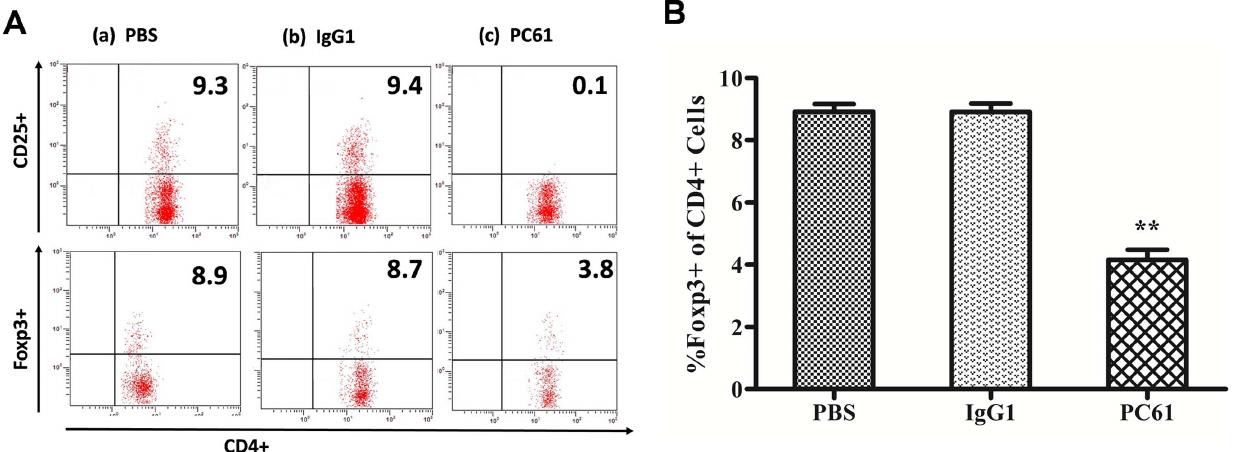
Figure 4. Effect of the injection of PC61 mAb on the Treg cells of normal mice. Mice (6 animals per group) were intraperitoneally injected with PBS (a), 200 m g of IgG1 mAb (b), or 200 m g of purified anti-CD25 mAb (PC61) (c). Two days after the injection, the spleen cells were collected. The numbers indicate the percentage of CD4 + CD25 + cells within the CD4 + population and the percentage of Foxp3 + cells within the CD4 + population. The values show the means 6 SEM. ** P , 0.01 compared with the PBS- and the IgG1-treated groups.